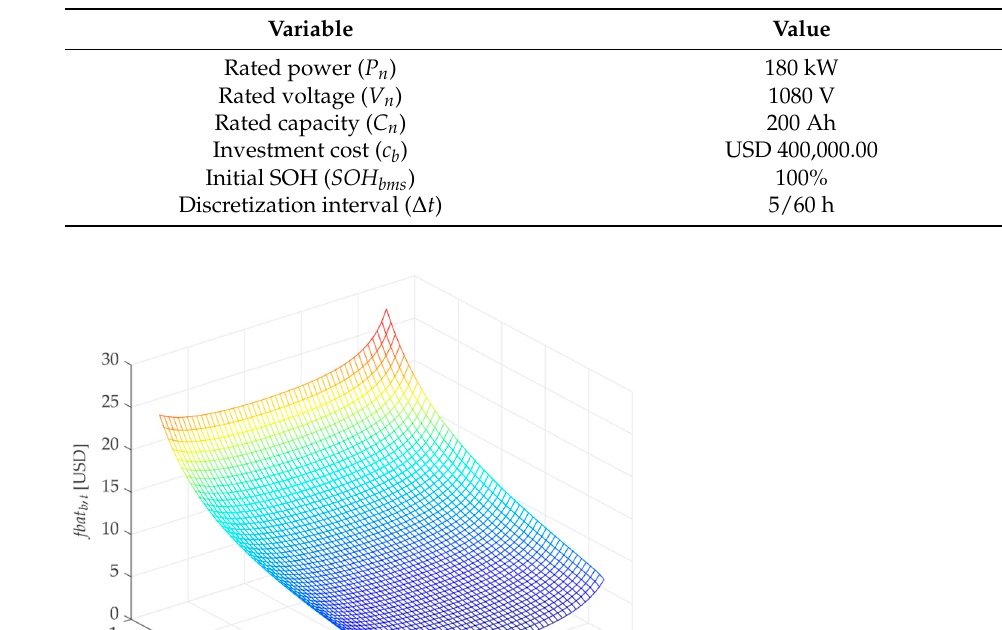
Table 2. BESS parameters. Figure 4. Influence of the temperature: ( a ) number of cycles and ( b ) f Δ SOH,T .